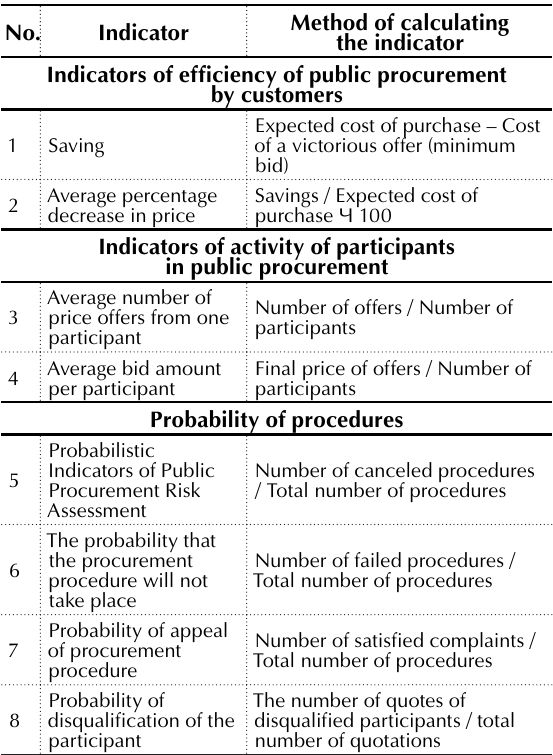
Table 2. Key indicators that characterize the efficiency of public